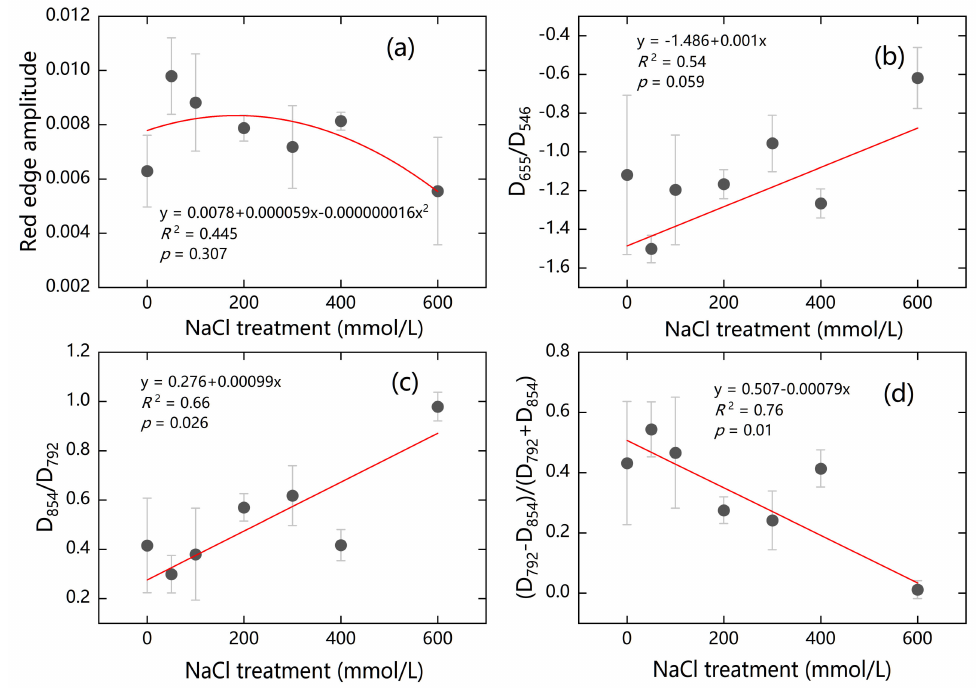
Figure 10. Relationship between applied salt concentration and red edge amplitude ( a ) and optimal vegetation indices D 655 / D 546 ( b ), D 854 / D 792 ( c ) and (D 792 − D 854 ) / (D 792 + D 854 ) ( d ). Error bars represent the standard error of the red edge amplitude and the average of the best vegetation indices (n = 3). The red curve represents the best fit